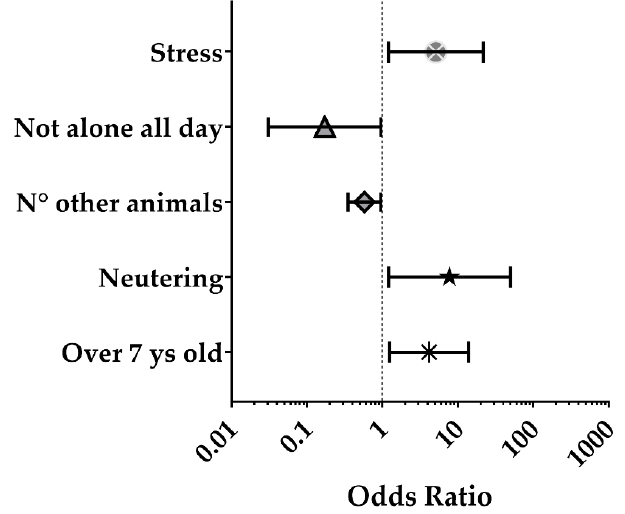
Figure 2. Forest plot of the parameters significantly associated with overweight: results of the multivariable analysis (adjusted OR and 95% CI). The detailed description of the variables and the reference categories are shown in Table S5.